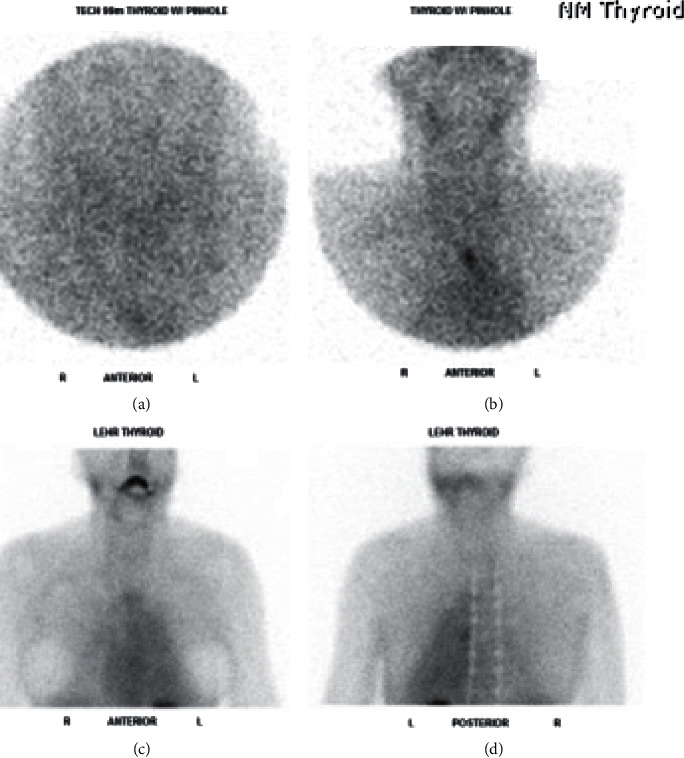

99m-STS showed failure of localization of the tracer within the thyroid gland, by imaging criteria suggesting destructive effect of amiodarone to the function of the gland and confirming AIT-2 (a, b) 15 minutes delay high- and low-resolution images. (c, d) 1 hour delayed anterior and posterior images.